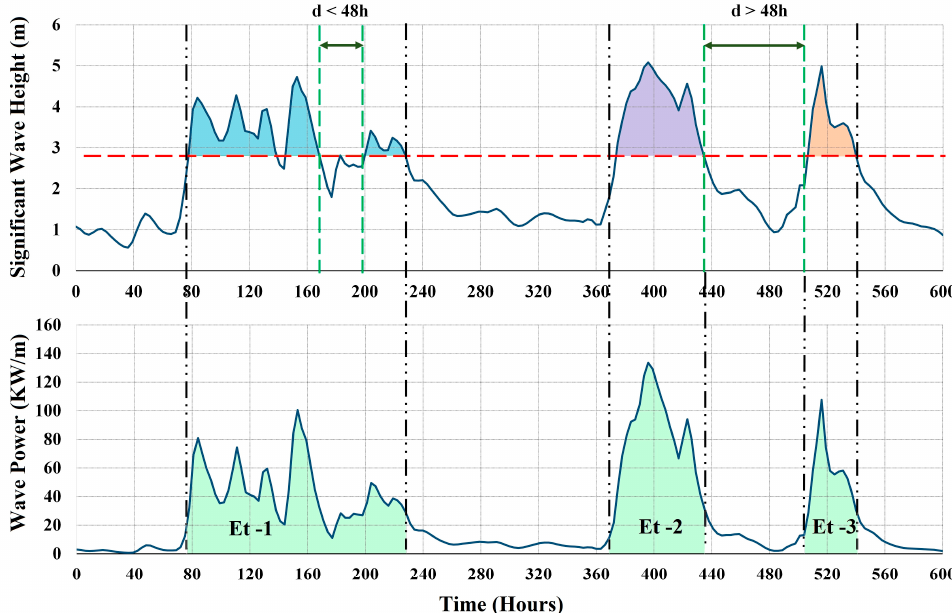
Figure 2. Time series plot illustrating three storm waves (distinguished by colors) characterized for a significant wave height threshold of 2.7 m with a minimum interval between two consecutive storms of 48 h.